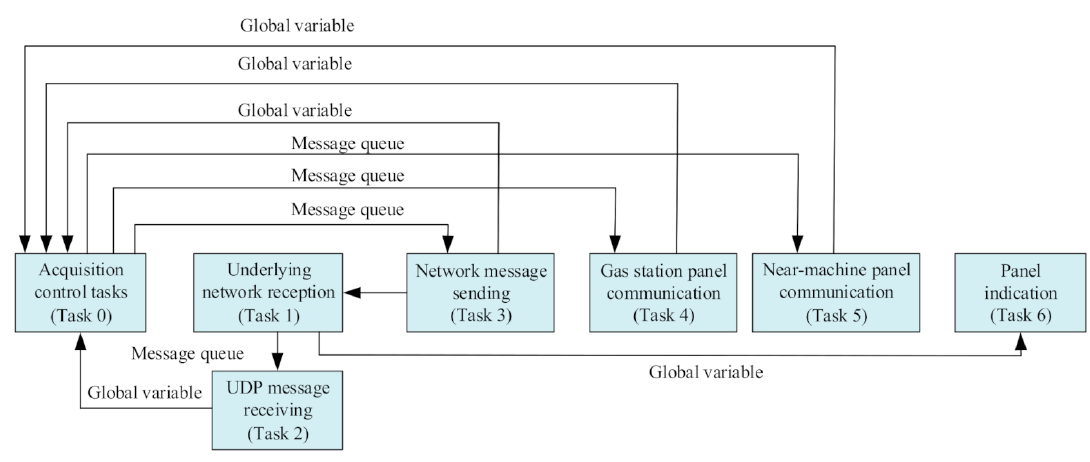
Figure 6. Division and connection among system tasks: